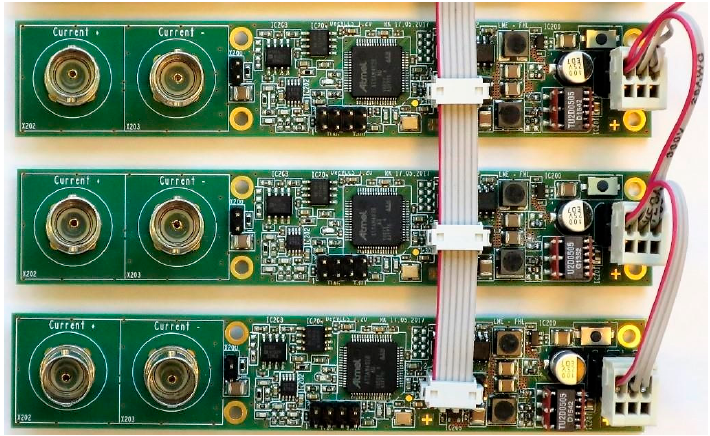
Figure 5. Photograph of three current source modules, connected in daisy chain mode.